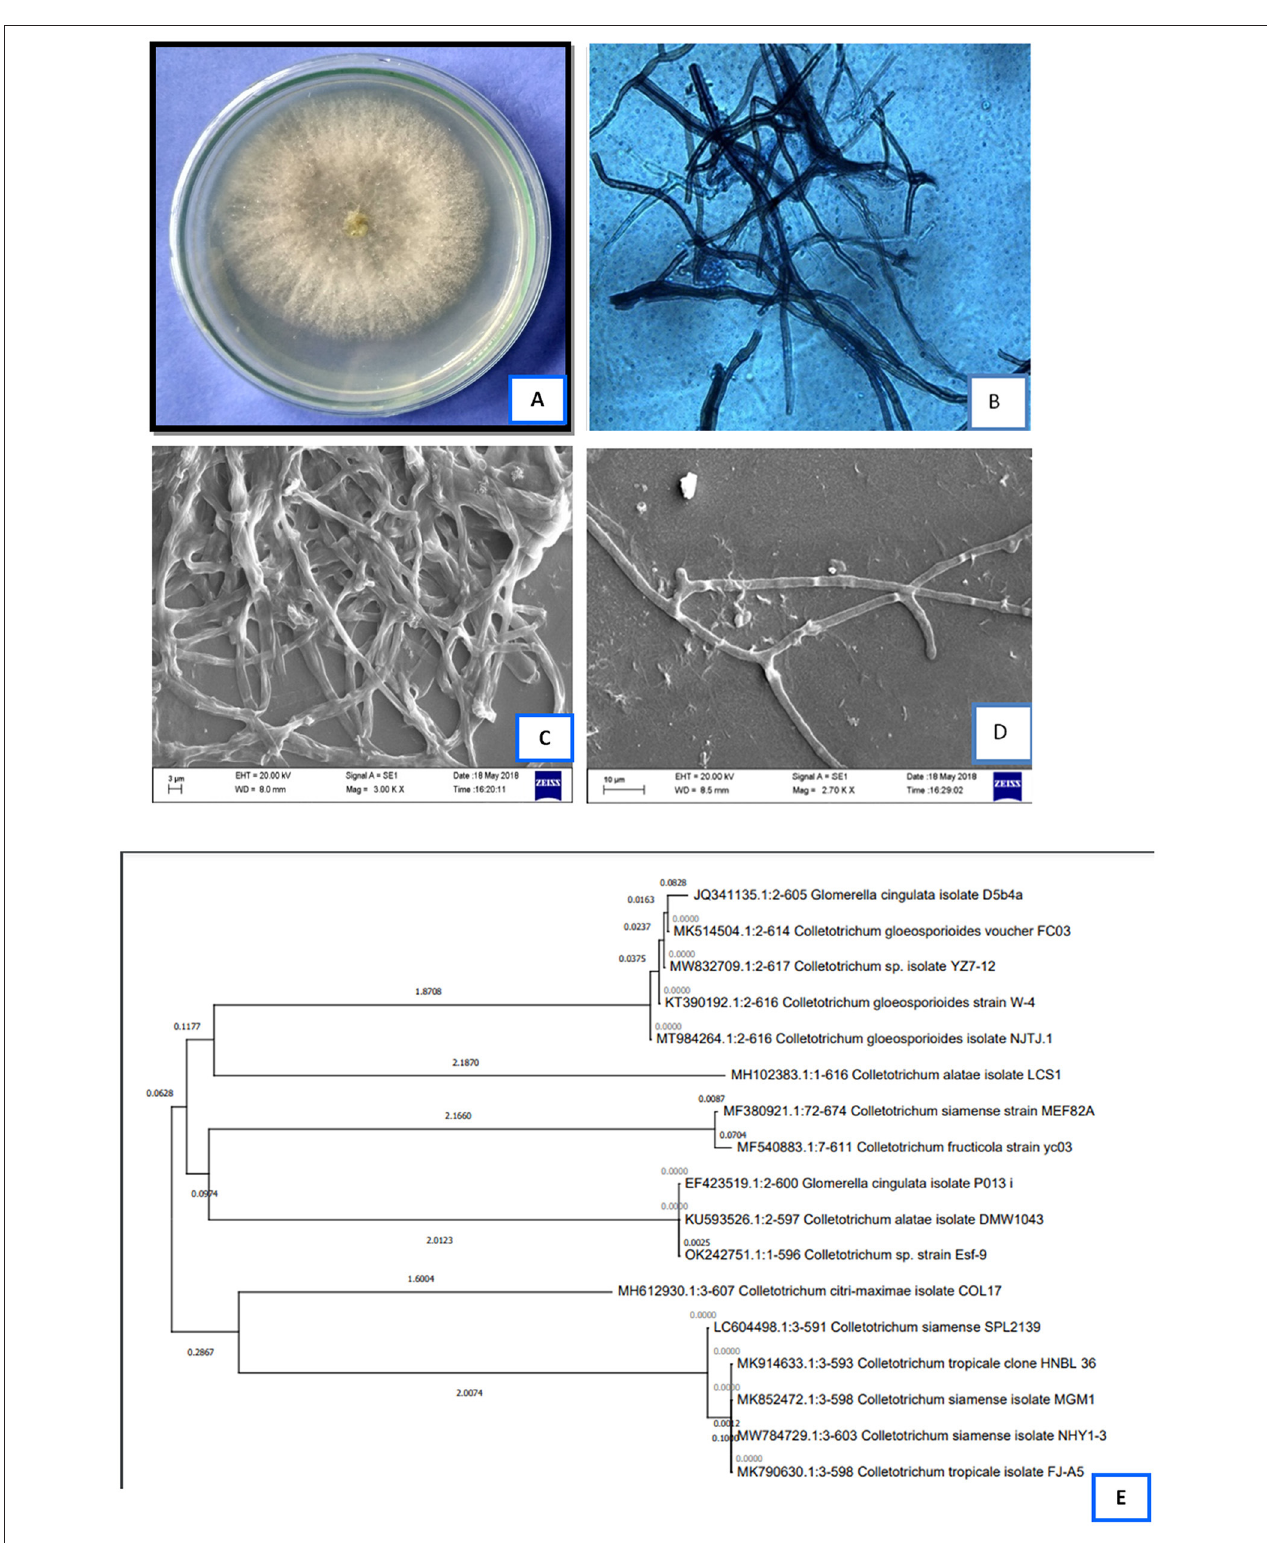
FIGURE 1 | (A) -plate morphology with top view, (B) -light microscopic photograph of the isolate, (C,D) -scanning electron microscopic image of the sterile hyphae, (E) -phylogenetic analysis of the endophytic Colletotrichum alatae LCS1.